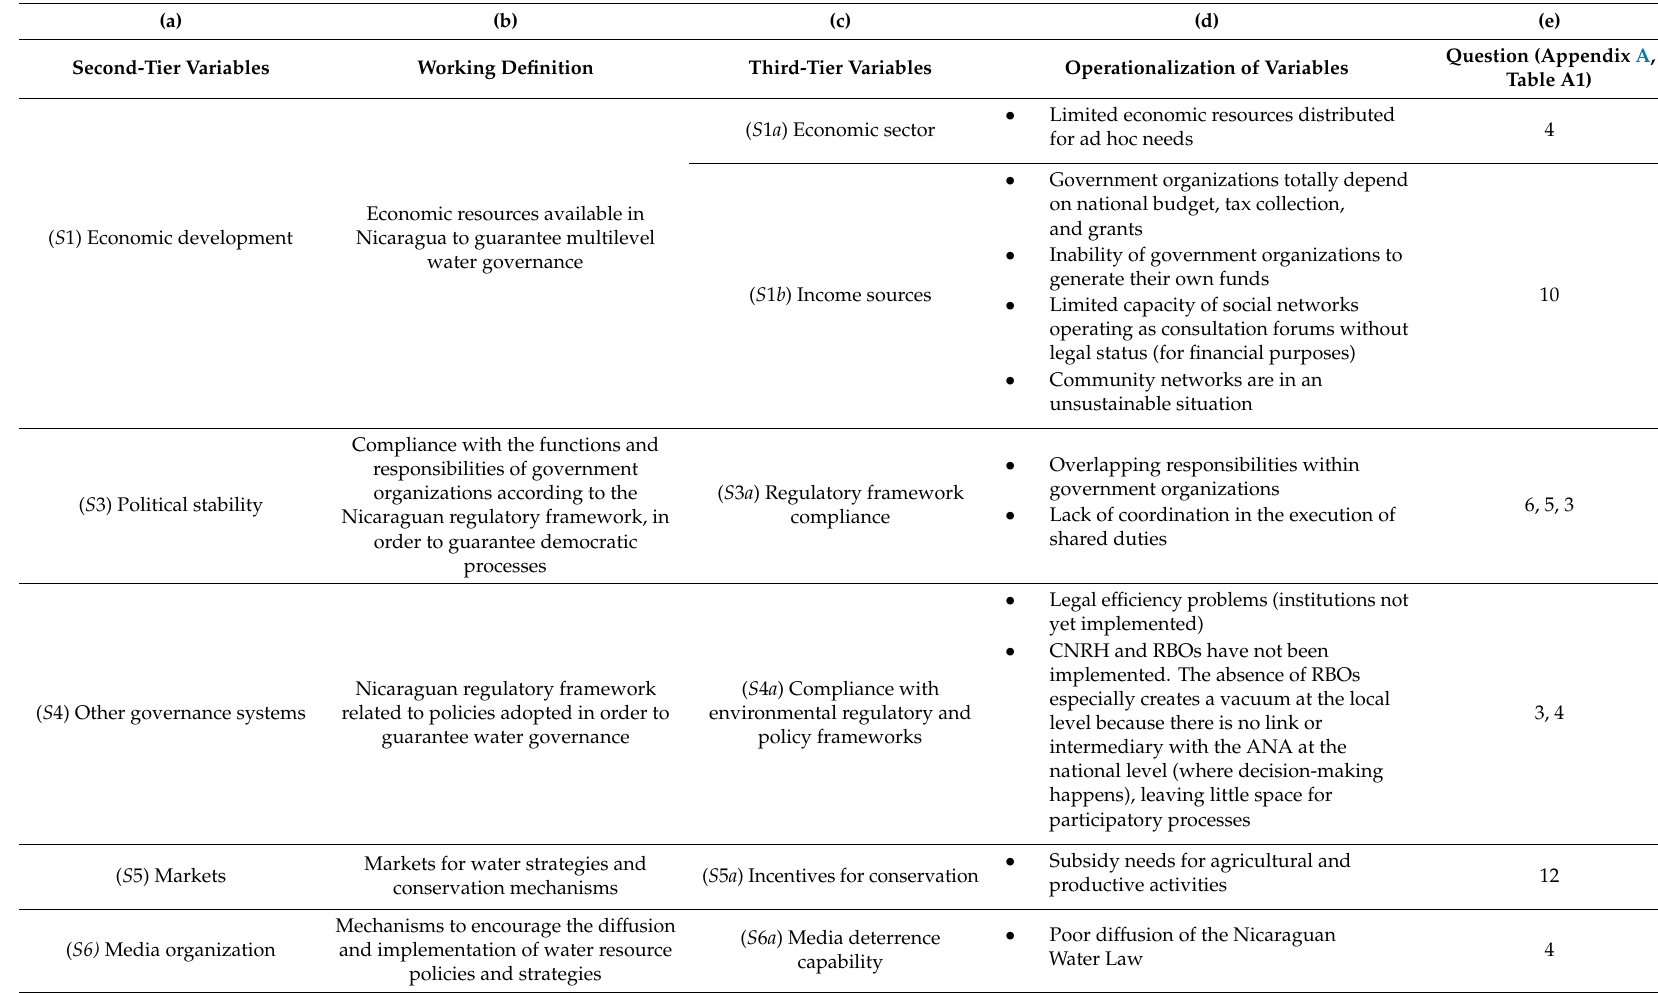
Table 4. Third-tier variables of social, economic, and political settings ( S ), as identified by the